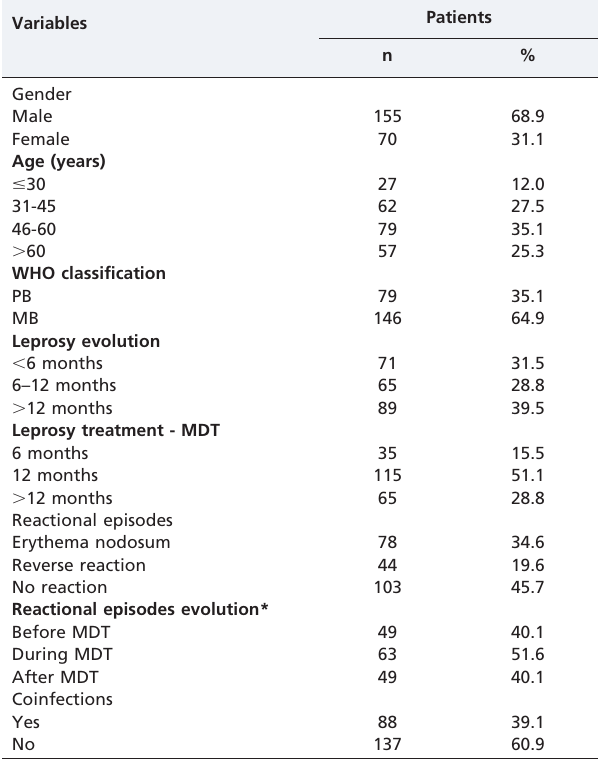
Table 1 - The number (n) and row percentages (%) of the demographic and clinical data from the leprosy patients managed at the Leprosy Clinics of the Ribeira˜o